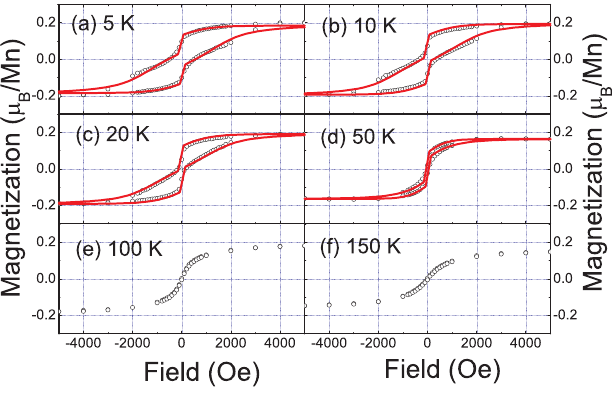
Figure 19 . Hysteresis loops (open circles) measured in the temperature range from 5 K to 150 K. The solid curves (a–d) are fittings using the Preisach model. (Reprinted with permission from Ref. [80]. Copyright 2009 by the American Physical Society).